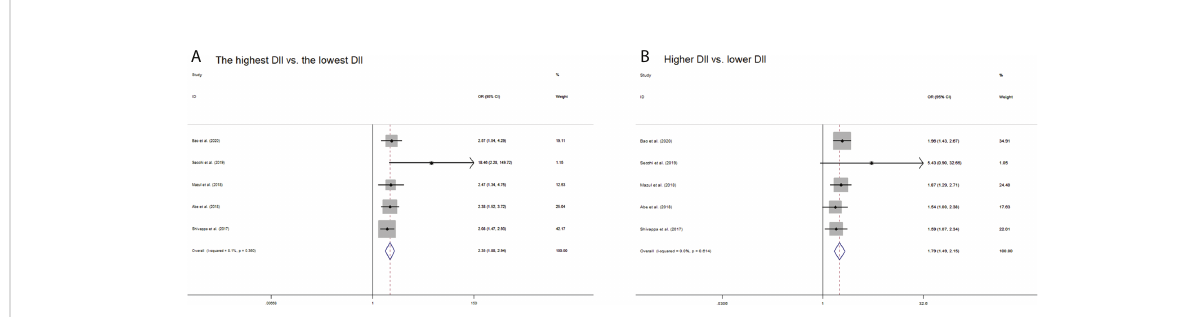
FIGURE 2 Forest plots of pooled odds ratios (ORs) with corresponding 95% con fi dence intervals (CIs) of oral cancer risk for (A) the highest DII versus the lowest DII and (B) higher DII versus lower DII.